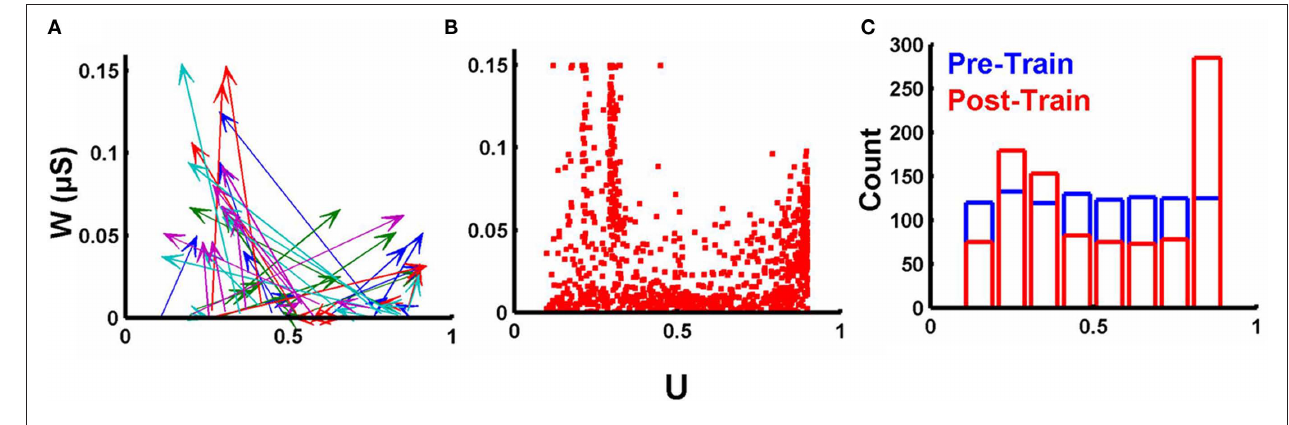
training. Arrow colors reflect each of the five output units (each trained to recognize a different pattern). (B) Final values of w and U for all synapses across all 20 experiments. (C) Initial (blue) and final (red) distribution of U values across all